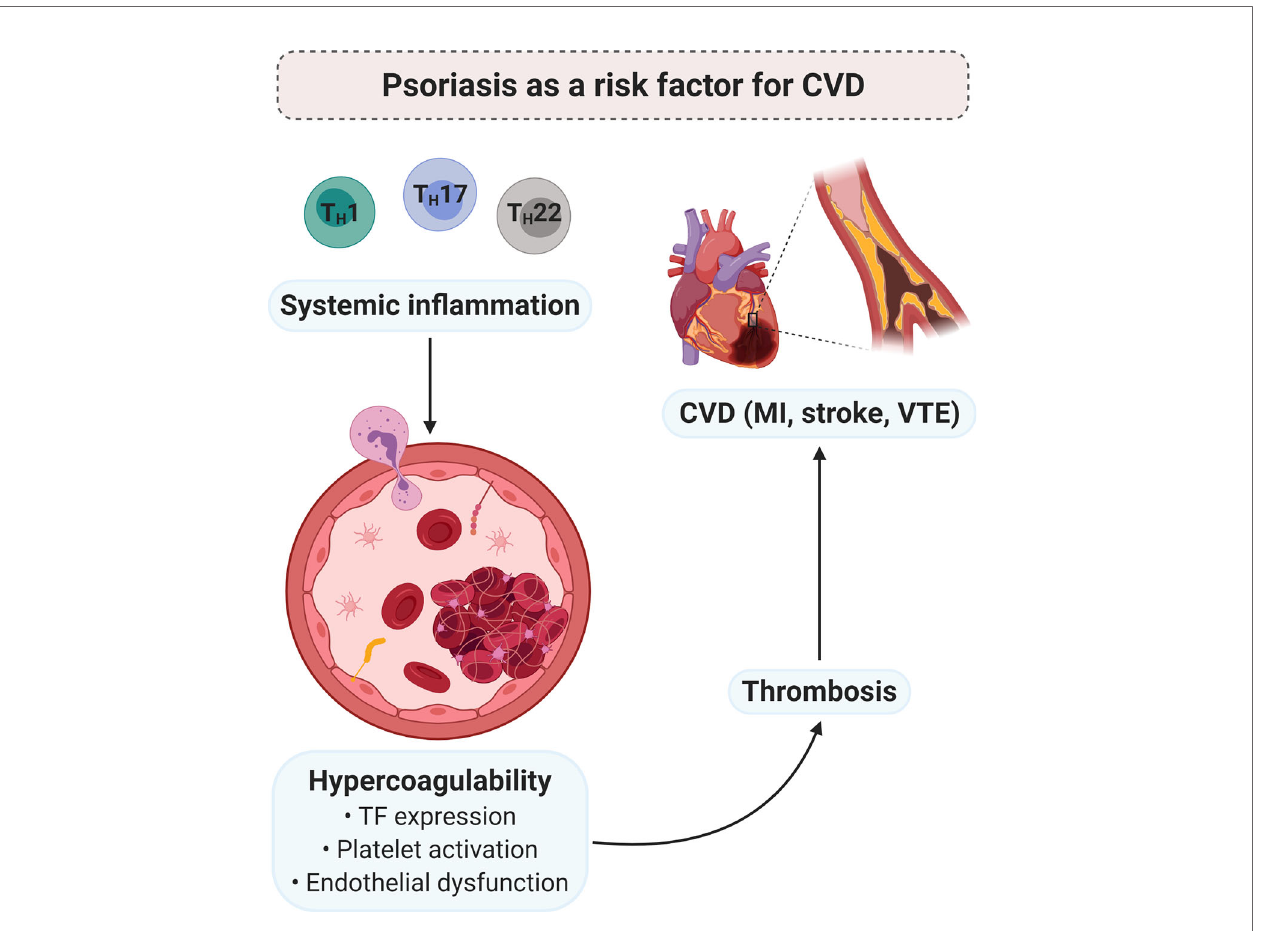
FIGURE 4 | PsO as a risk factor for CVD. Chronic low-grade systemic in fl ammation, due to psoriatic pathology, may contribute to the development of a hypercoagulable state. Pro-in fl ammatory mediators induce the expression of TF, enhance platelet activation and/or the platelet response, and endothelial dysfunction. In turn, hypercoagulability predisposes thrombosis, which is the major underlying pathology of CVD. Diagram created with BioRender.com. CVD, cardiovascular disease; MI, myocardial infarction; TF, tissue factor; T H , T helper; VTE, venous